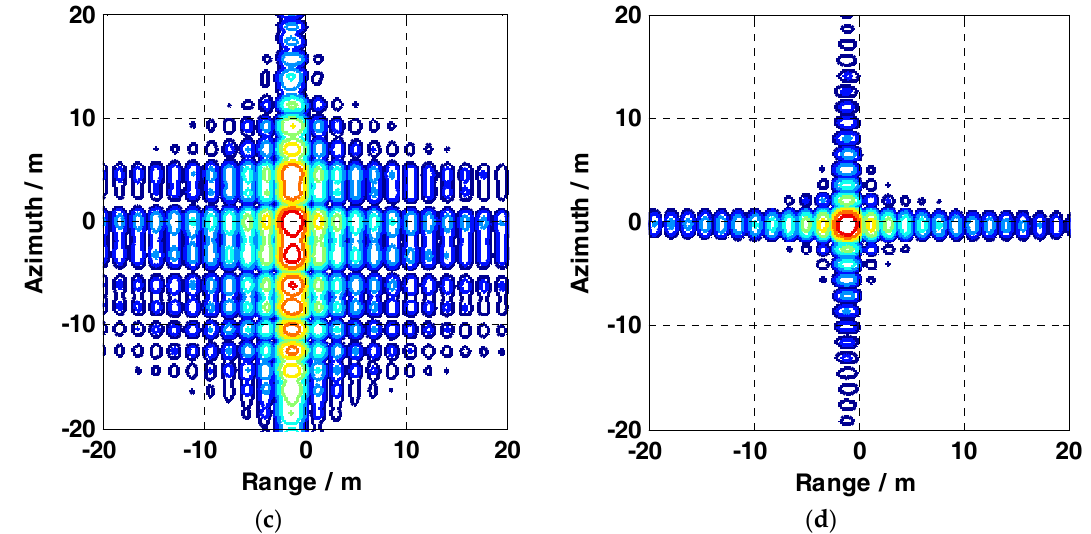
Figure 7. Target 5’s contours processed by ( a ) the conventional SAR imaging algorithm (CS algorithm), ( b ) MD algorithm, ( c ) PGA algorithm, and ( d ) BLUE algorithm, for sliding spotlight SAR data with intensive accelerated motion error.